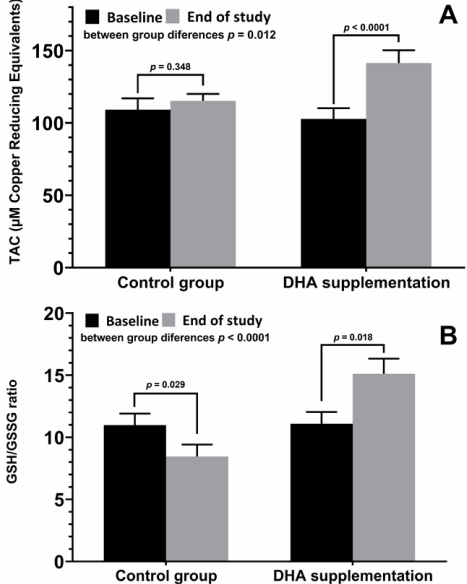
Figure 1. ( A ) Changes of plasma levels of TAC (mean ± SD) at baseline and at the end of the study in patients treated with DHA supplementation and controls, with significant increases in the DHA group ( p < 0.0001) and significant between-group differences ( p = 0.012). ( B ) Changes of GSH/GSSG ratio (mean ± SD), with a significant decrease in controls ( p = 0.029) as opposed to a significant increase in the DHA group ( p = 0.018), with significant between-group differences ( p <